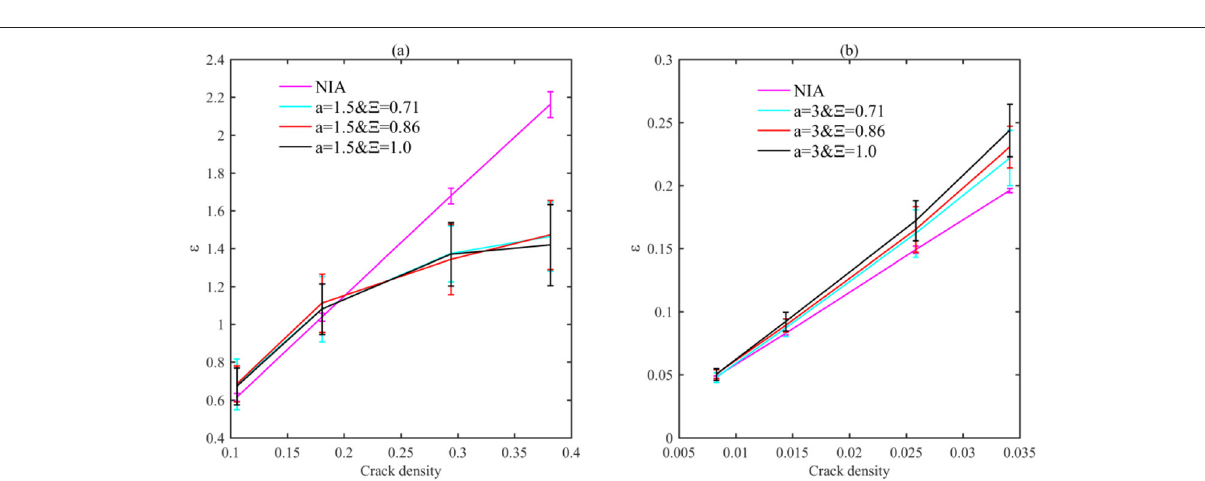
FIGURE 8 | Anisotropic parameters ε , as the function of fracture density, are presented for various rock samples. The bar centers correspond to the averaged values of the numerical ε ; the bar sizes define their standard deviations. In the legend, 4 is the aspect ratio for the ellipse boundary of the fracture clustering, while a = 1.5 (A) and 3 (B) correspond to long and short fractures, respectively. The numerical result bars are in line with those in Figure 6